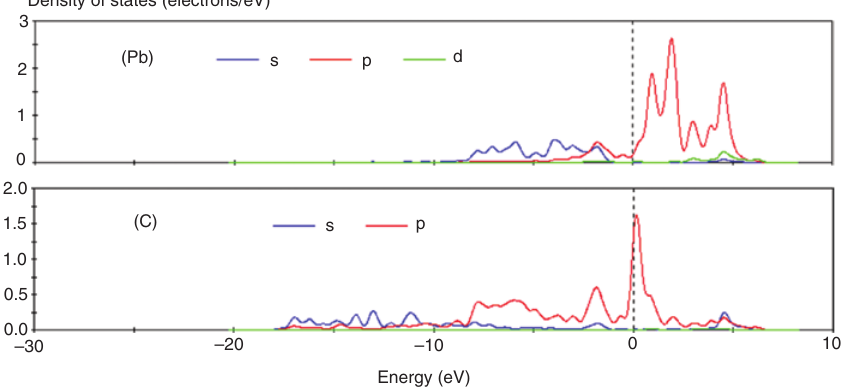
Figure 3: The PDOS of C and Pb in Pb 2 + -SV-(6, 0)